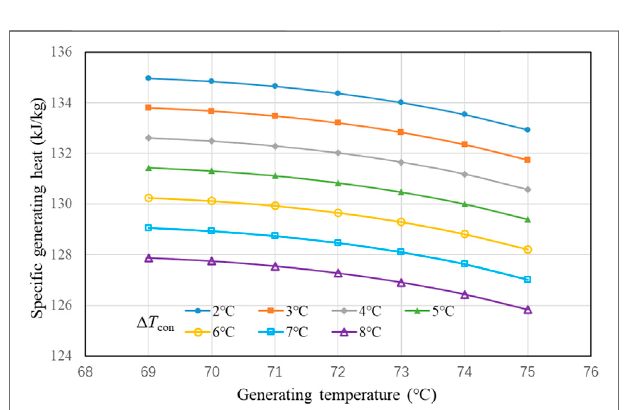
FIGURE 9 | Time cost for the cooling process in step